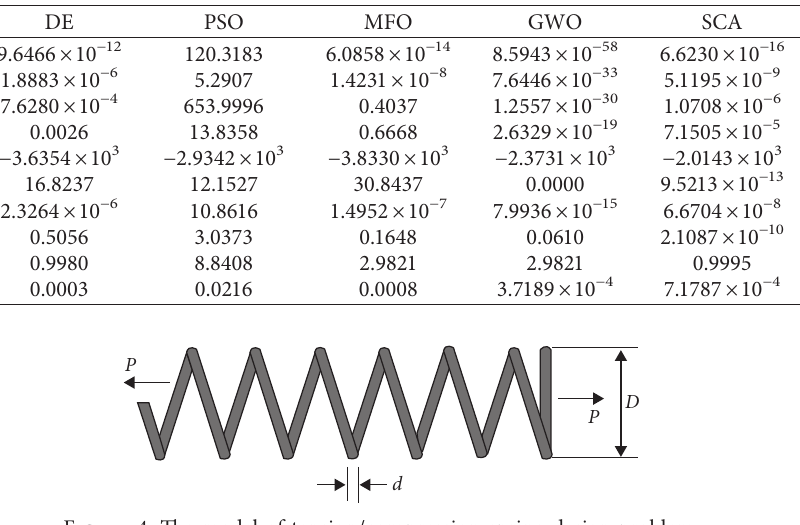
Table 3: Optimal values of the benchmark functions.